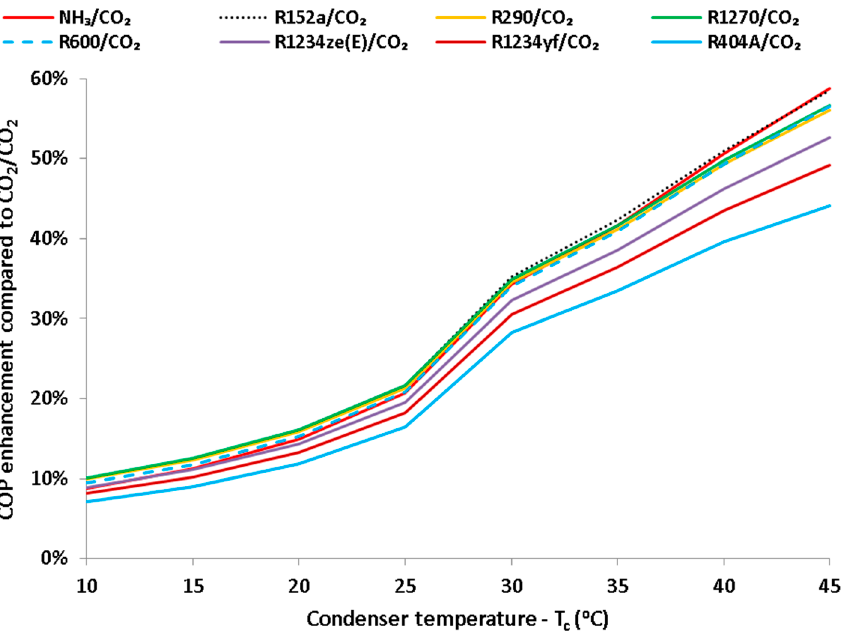
Figure 7. COP enhancement compared to the CO 2 /CO 2 system of various systems with T e = − 35 °C.